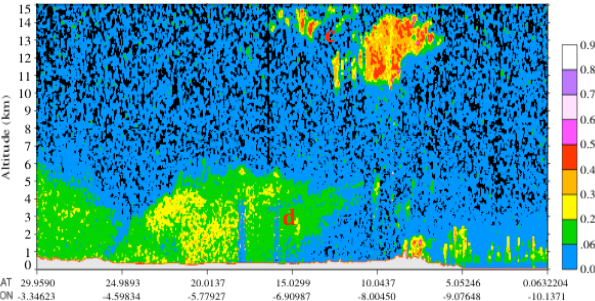
Fig. 15. The 532-nm depolarization ratio for Asian dust on 23 May 2007. Red characters “c” and “d” represent “clouds lay- ers” and “dust plumes”,